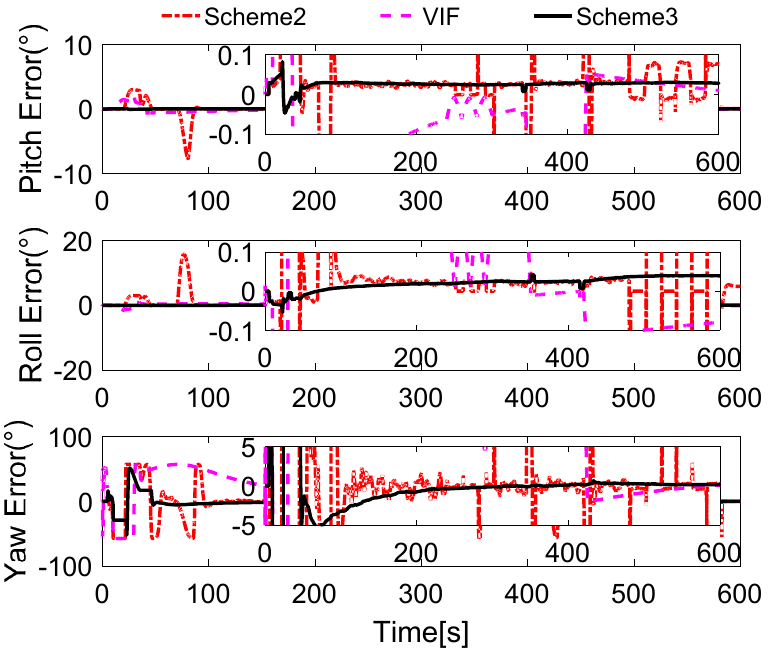
Figure 12. Curves of alignment errors.